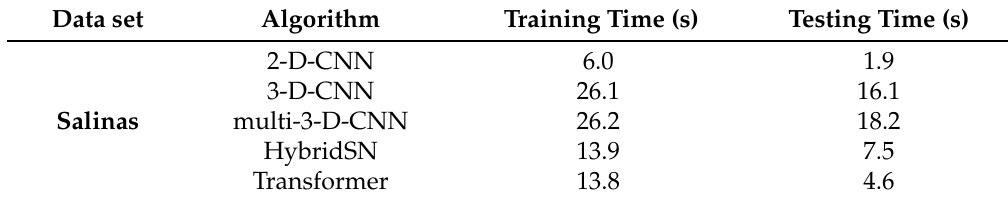
Table 14. Running time of the five methods on the Salinas data set. Data set